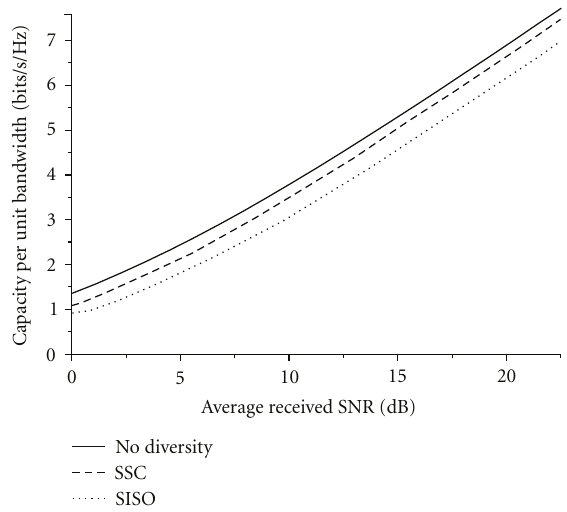
Figure 3: Capacity per unit bandwidth of a dual branch Nakagami- m fading channel with SC diversity as a function of the average received SNR.